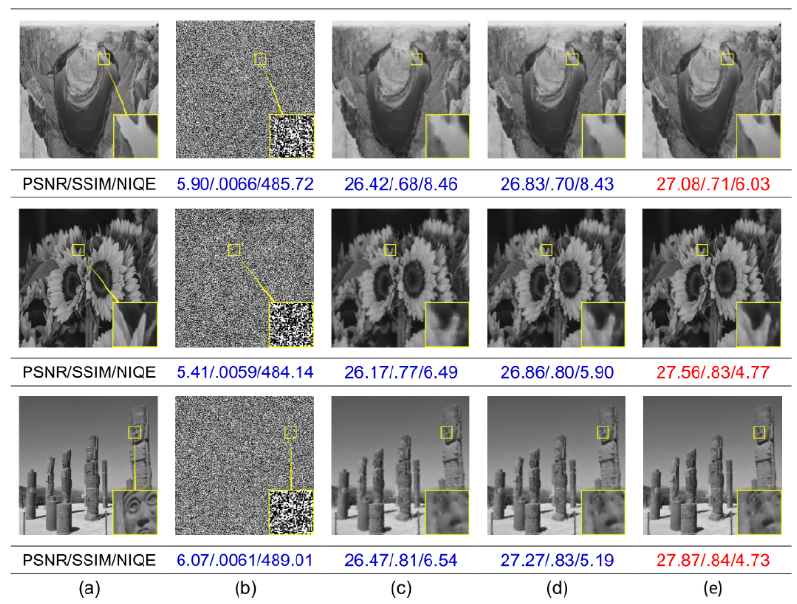
Figure 7. Ablation study of the proposed denoising framework based on subjective comparisons. We show the corresponding objective scores below the measured images. The best scores are in red. ( a ) Original image. ( b ) Image with 90% noise added. Denoising results using ( c ) AOAF, ( d ) AOAF+Conv, and ( e )